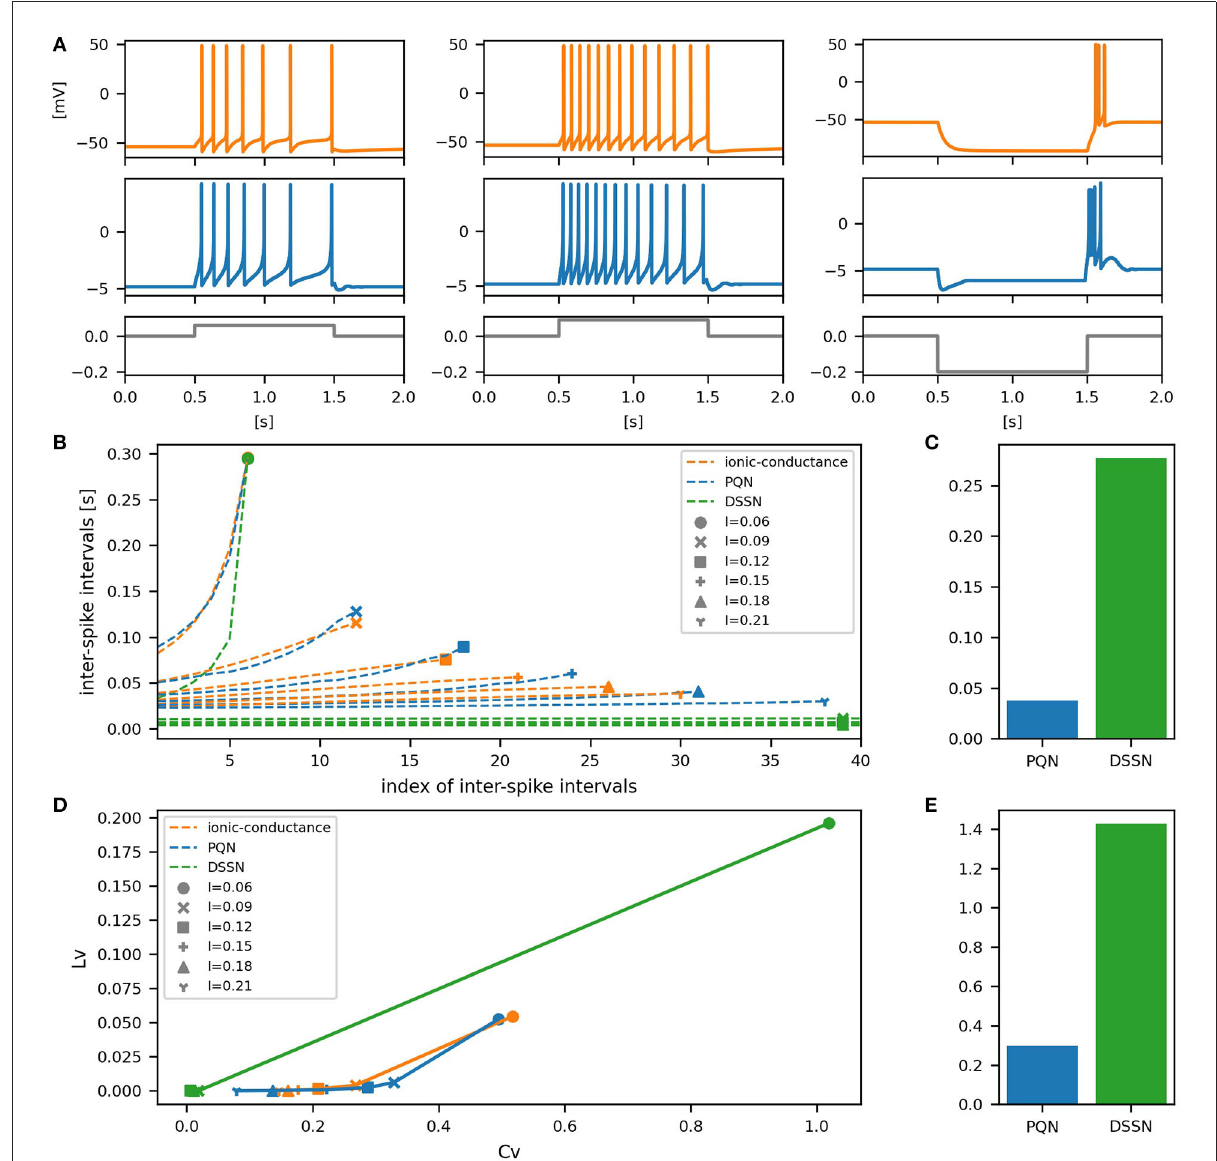
FIGURE9 Waveforms and spiking properties in LTS mode. (A) Waveforms of the ionic-conductance model (orange) and the PQN model (blue). Gray lines represent stimulus inputs. (B) The transitions of ISIs are shown while increasing the magnitude of the stimulus input. (C) The mean square errors of the PQN model and the DSSN model with the ionic-conductance model over the data points shown in (B) . (D) Values of the C V and L V were calculated from the waveforms and plotted while varying the magnitude of the stimulus inputs. The waveforms used here are the same as that used in (B) . (E) The mean square errors of the PQN model and the DSSN model with the ionic-conductance model over the data points shown in (D) .